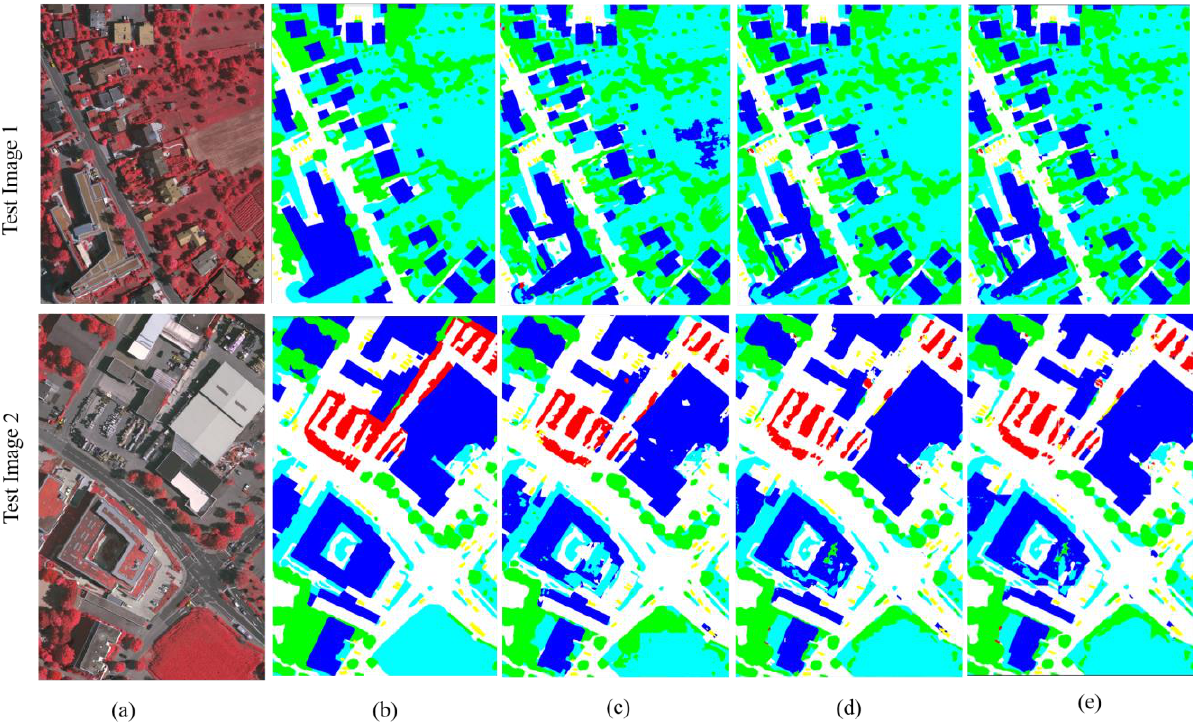
Figure 7. Semantic segmentation result for two sample images from the ISPRS Vaihingen dataset. (a) Input image,